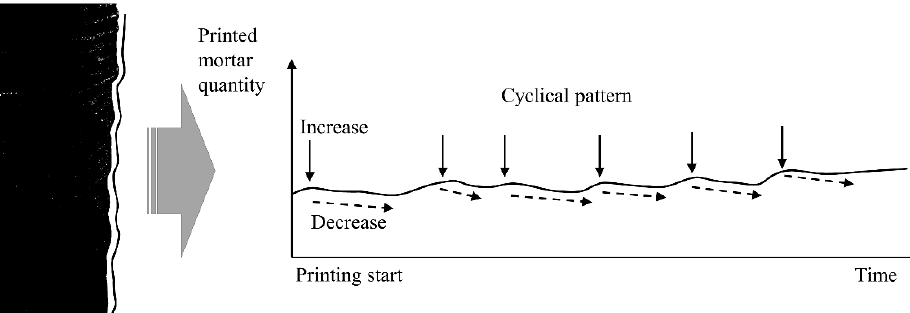
Figure 2. Cyclical pattern on printed layers over time in a real case.